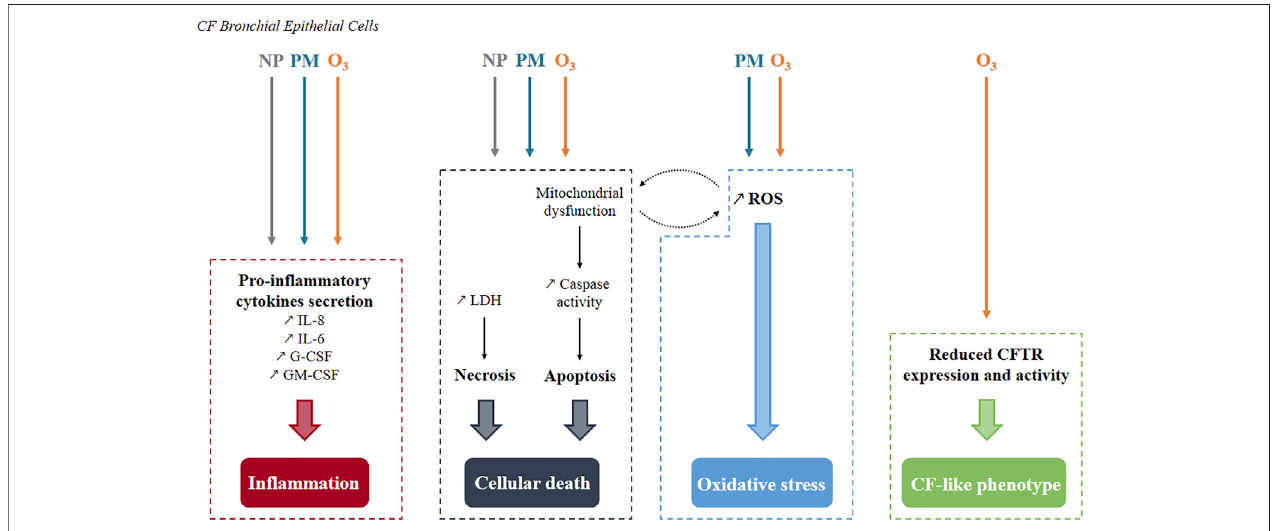
FIGURE 2 | Summary of pollutants ’ effects known so far in human CF bronchial epithelial cells. Three common cellular mechanisms have been identi fi ed. In fl ammation and cell death occur after exposure to either nanoparticles, particulate matter or ozone while oxidative stress is generated only by particulate matter and ozone. Mitochondrial dysfunction and reactive oxygen species production are interconnected as they stimulate each other. Speci fi cally to ozone, aCF-like phenotype is produced with decreased CFTR expression and activity. NP, Nanoparticles; PM, Particulate Matter; O 3 , Ozone; ROS, Reactive Oxygen Species.